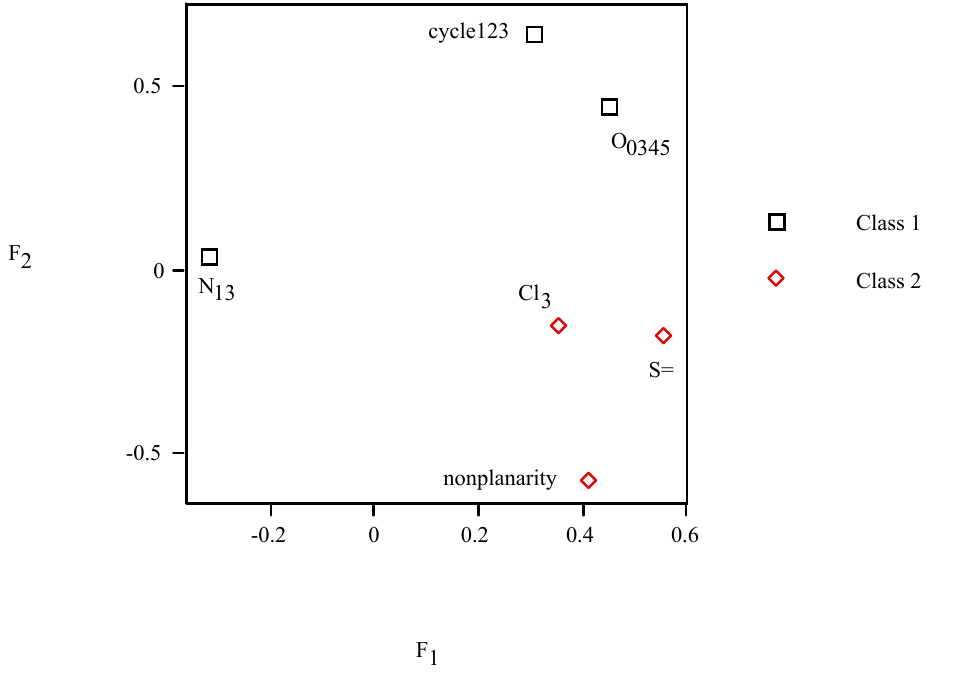
Figure 6. F versus F loadings plot of the principal component analysis for the 2 1